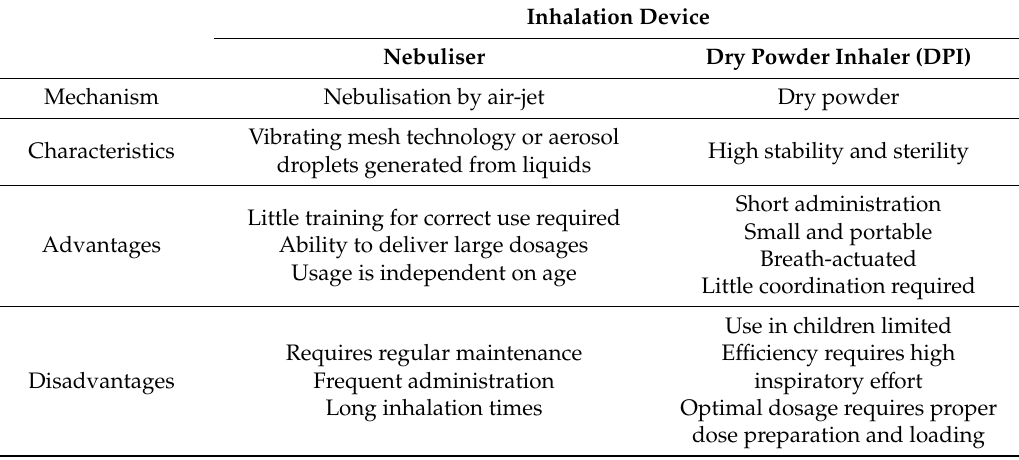
Table 3. Characteristics of inhalation devices commonly used for pulmonary